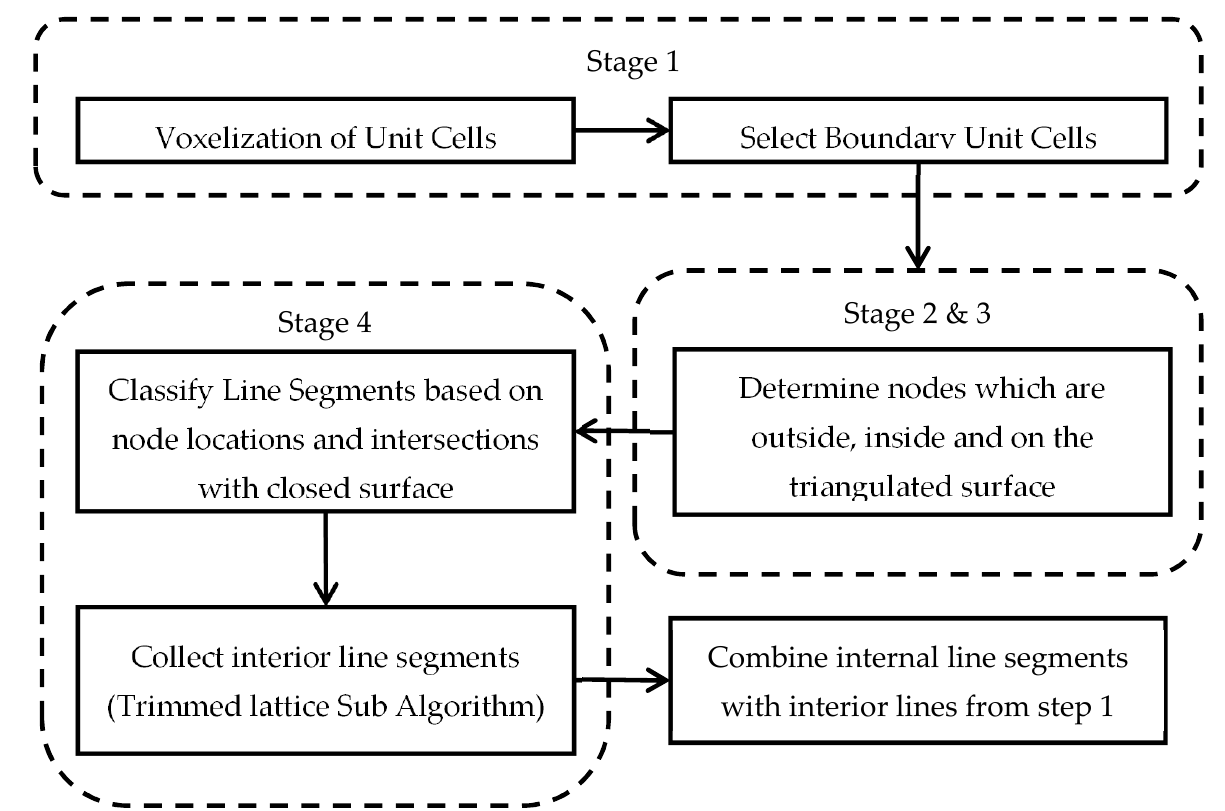
Figure 4. Interior trimmed lattice workflow.